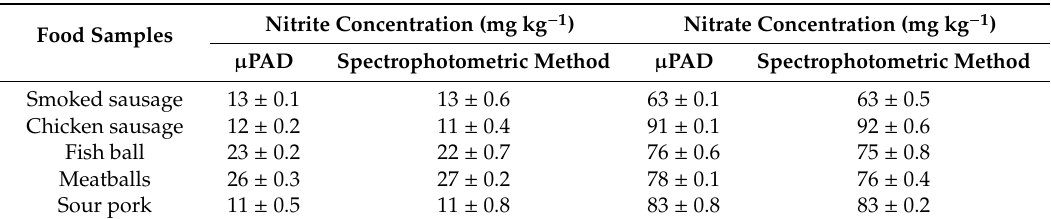
Table 2. Detection results of nitrite and nitrate in food samples using the µ PAD and spectrophotometric methods.